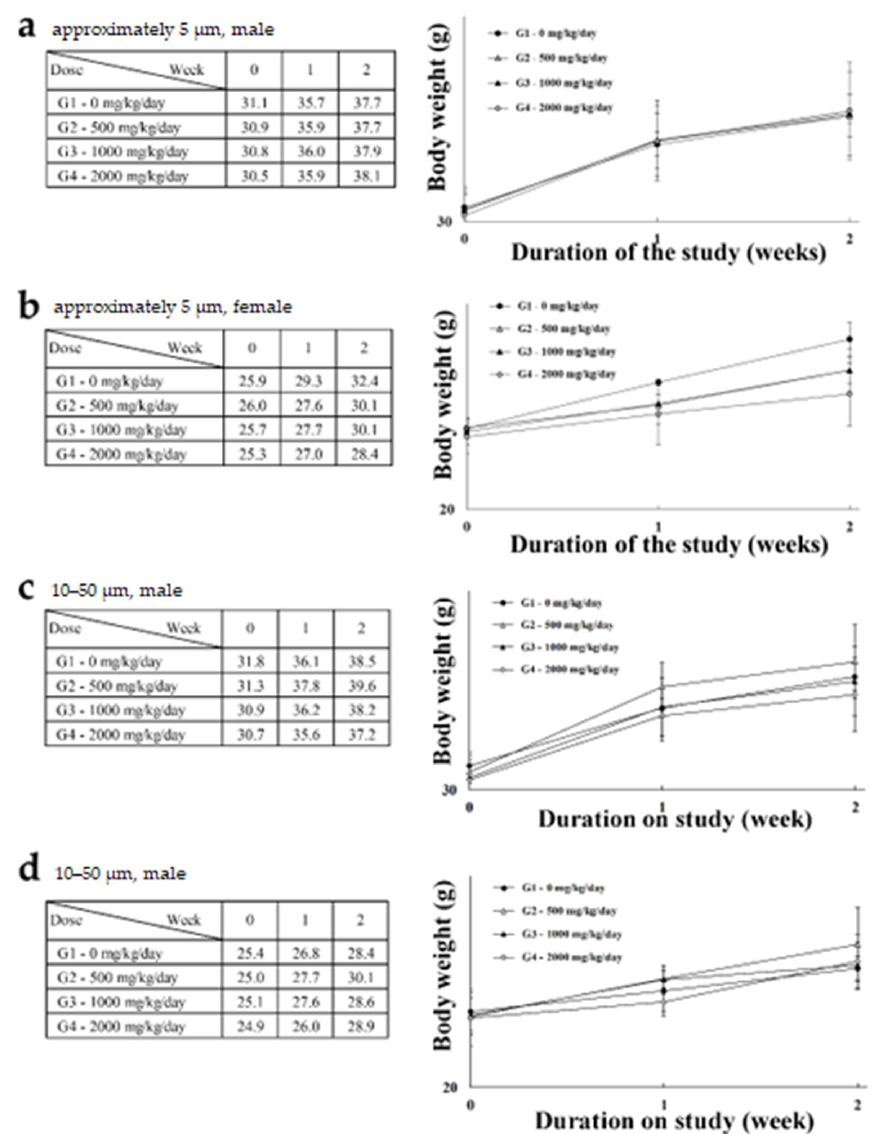
Figure 2. Male and female bodyweight changes after a single dose of approximately 5 μm ( a , b ) and 10‒50 μm ( c , d ) PTFE microplastics.